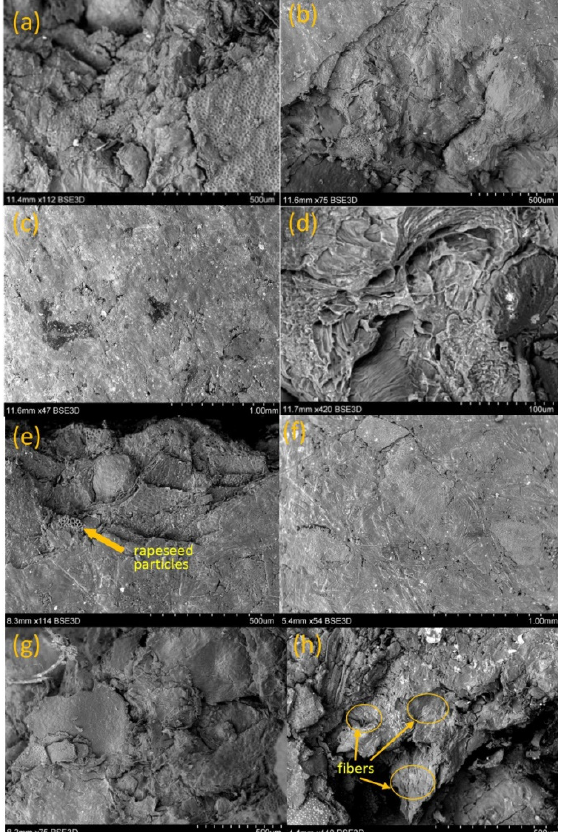
Figure 6. Scanning electron microscope (SEM) images of selected biocomposite samples: ( a ) sample fracture site ChPR (30_130), ( b ) sample fracture site ChPR (30_160), ( c ) sample surface ChPR (30_160), ( d ) close-up of the fibre embedded in the matrix ChPR (30_160), ( e ) sample (control 1), ( f ) APR sample area (30_160), ( g ) sample fracture site RPR (30_130), ( h ) sample fracture site APR